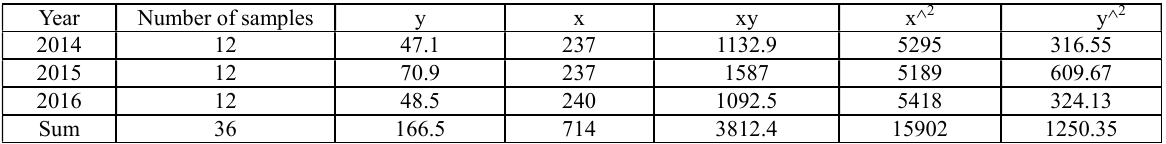
Table 5. Actual precipitation patterns from 2014 to